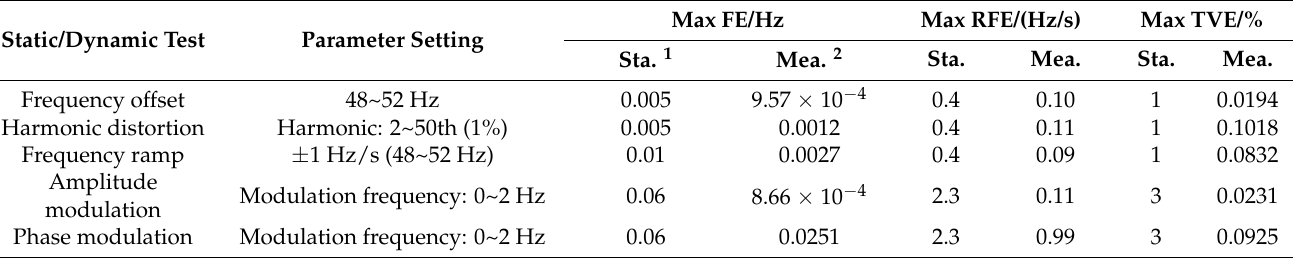
Table 2. Measurement Results of the PMU Prototype under Static and Dynamic Tests.